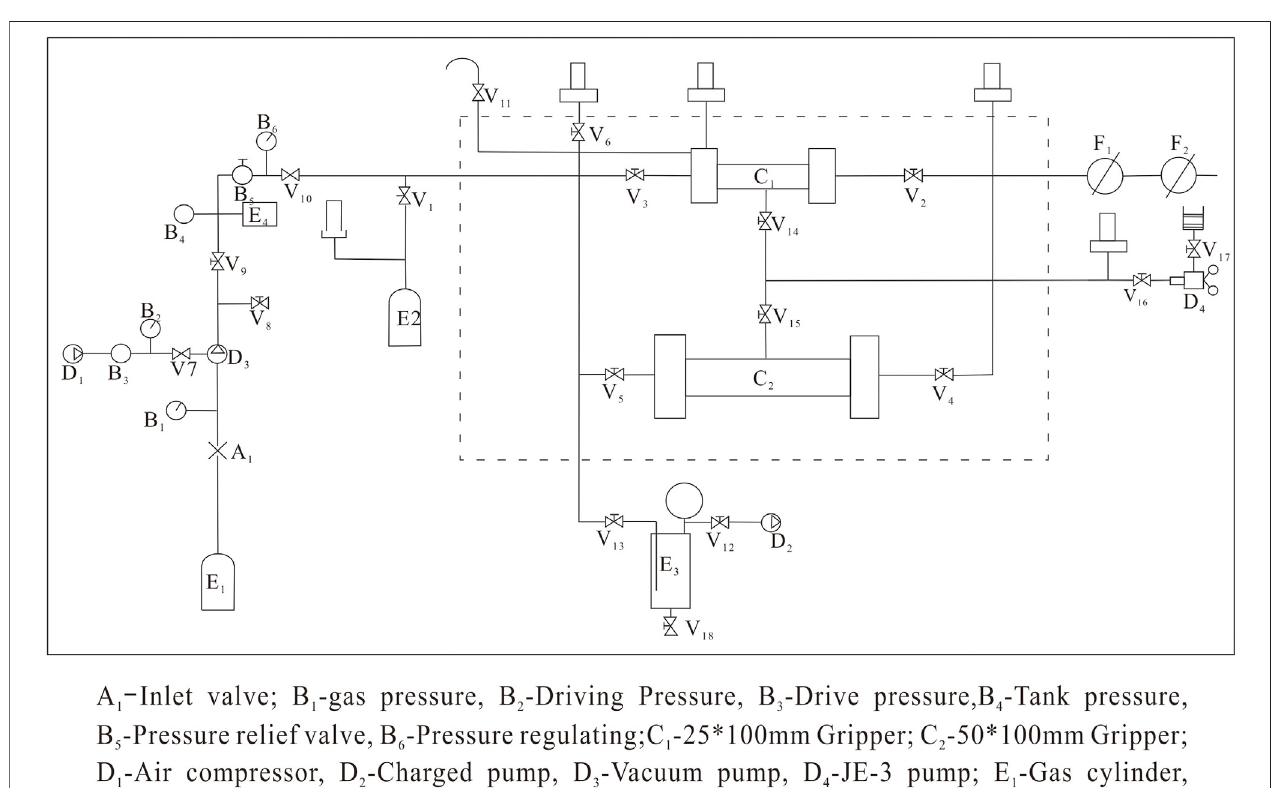
Frontiers in Earth Science |